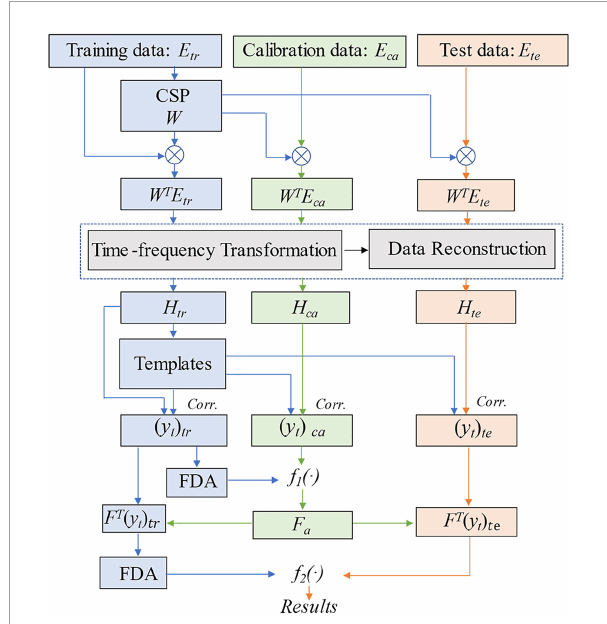
FIGURE2 Flow chart of the proposed tCSP. tr indicates training data, ca indicates calibration data, te indicates test data, H indicates the concatenated time-frequency data, Corr. indicates Pearson correlation, y t indicates the tCSP feature, F a indicates the optimal frequency point, f 1 ( · ) and f 2 ( · ) indicate decision